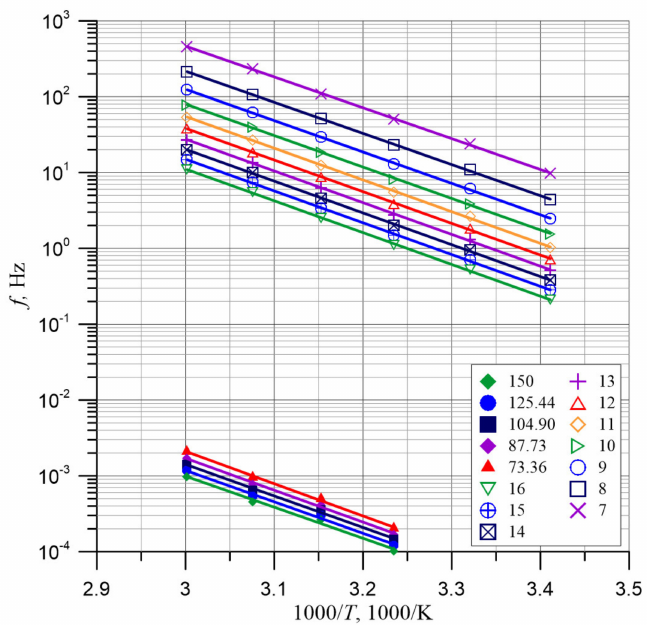
Figure 6. Arrhenius diagrams for determination of the permittivity activation energy of relax- ation time.